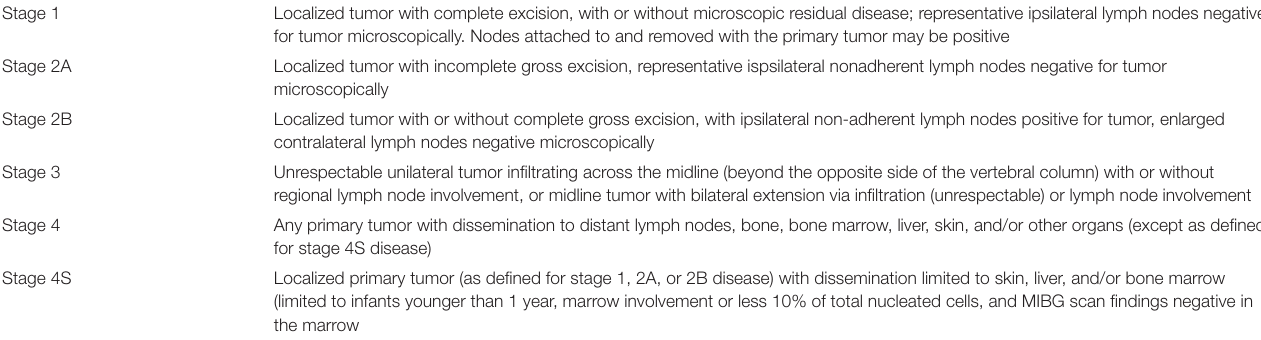
TABLE 3 | INSS Tumor staging system